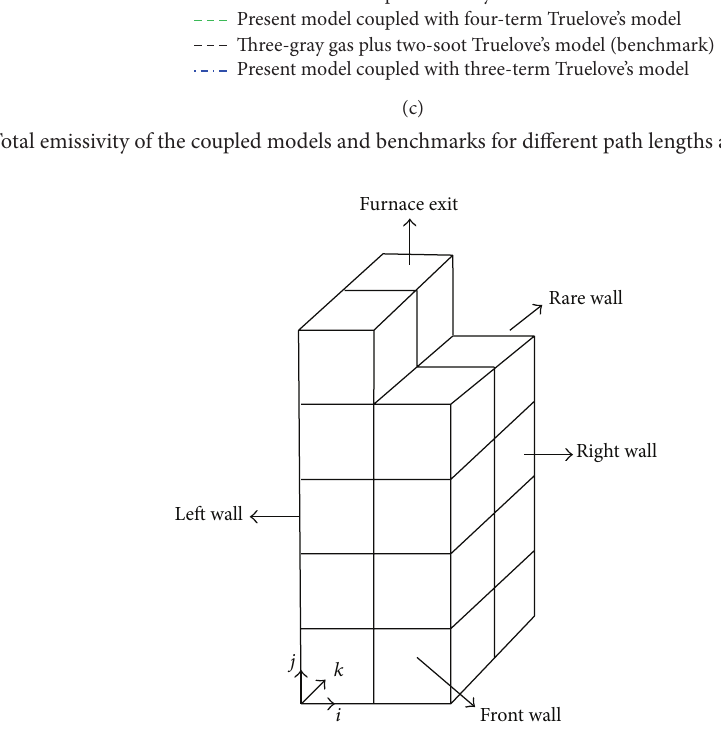
Figure 5: Schematic of the simplified model of the